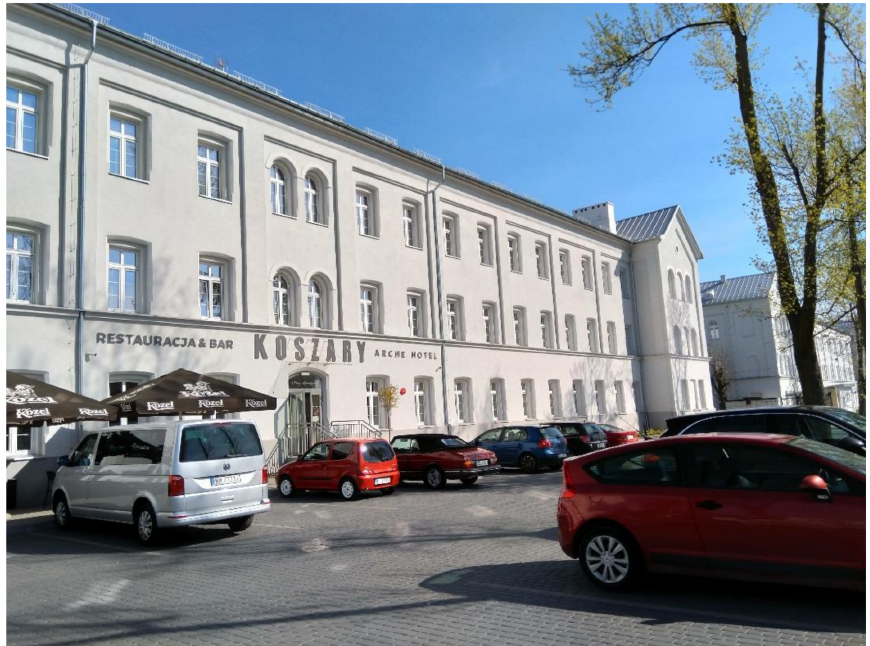
Figure 14. Rehabilitated barracks in G ó ra Kalwaria with an identification sign on the façade (photo by M.